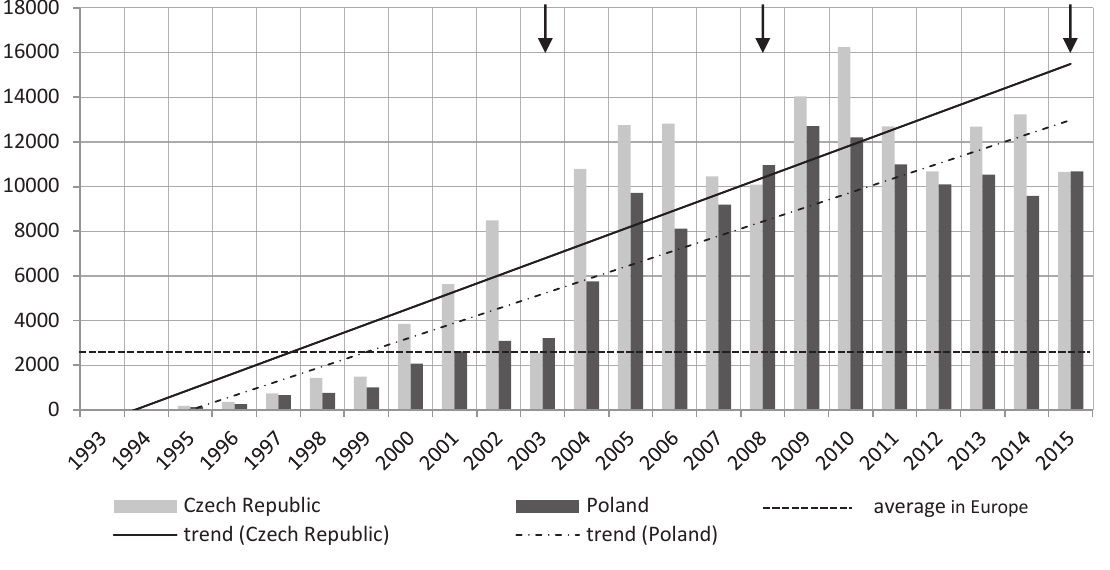
Figure 5. The number of the registered certificates in Poland and the Czech